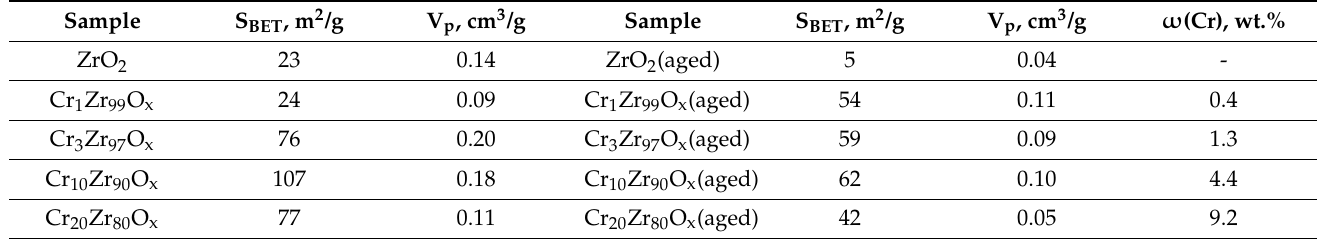
Table 1. Textural characteristics for two series of mixed oxides.